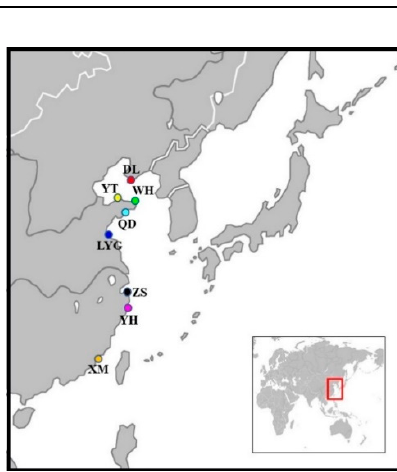
Figure 1. Sampling localities of A. rubrolineatus included in our analyses.